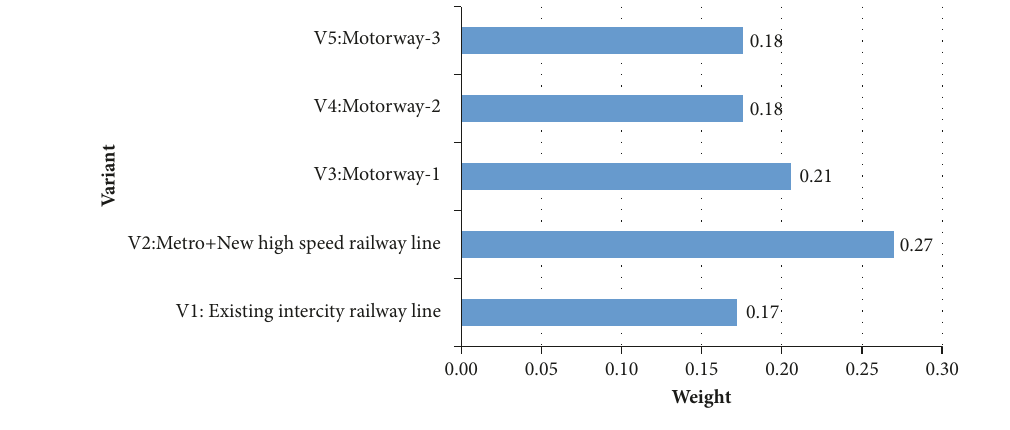
Figure 9: Priorities of alternatives. Table 2: Prioritization matrix of criteria and weights.